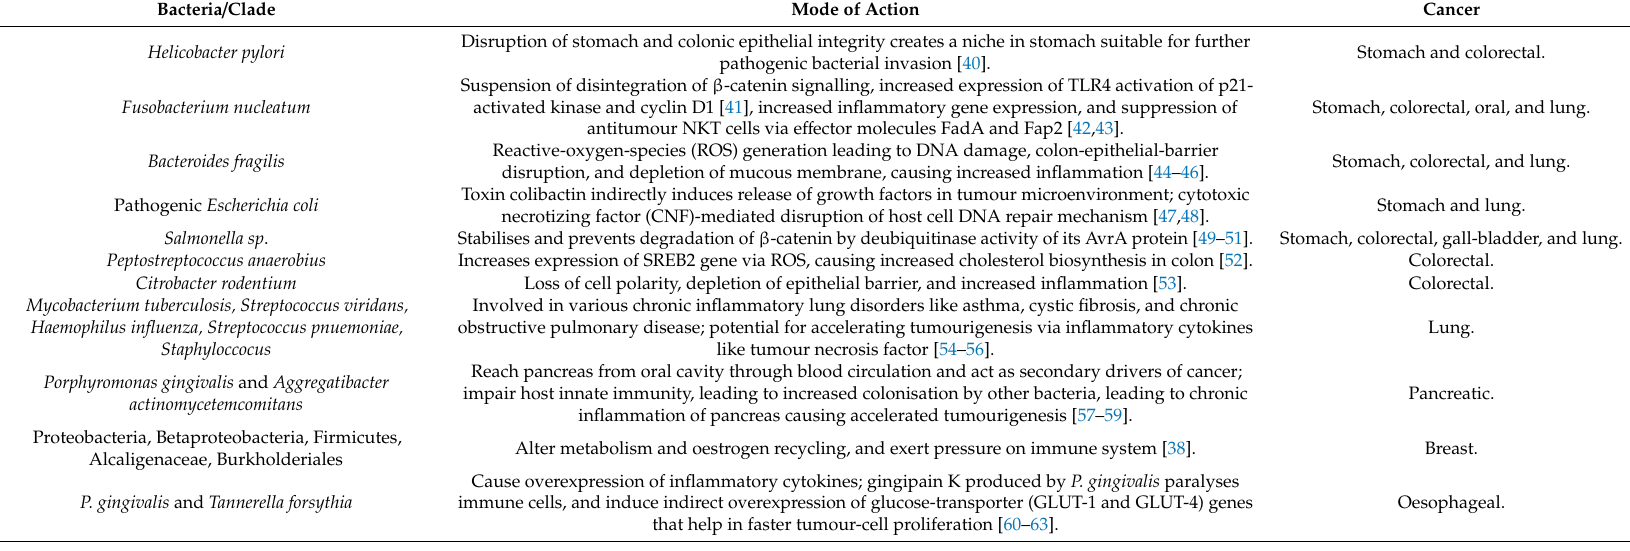
Table 1. Di ff erent pathogenic bacteria / bacterial clades, their possible mode of action, and cancer types with these bacteria. List is not exhaustive, but brings out some common modes of action by di ff erent bacterial clades in pathogenesis of di ff erent